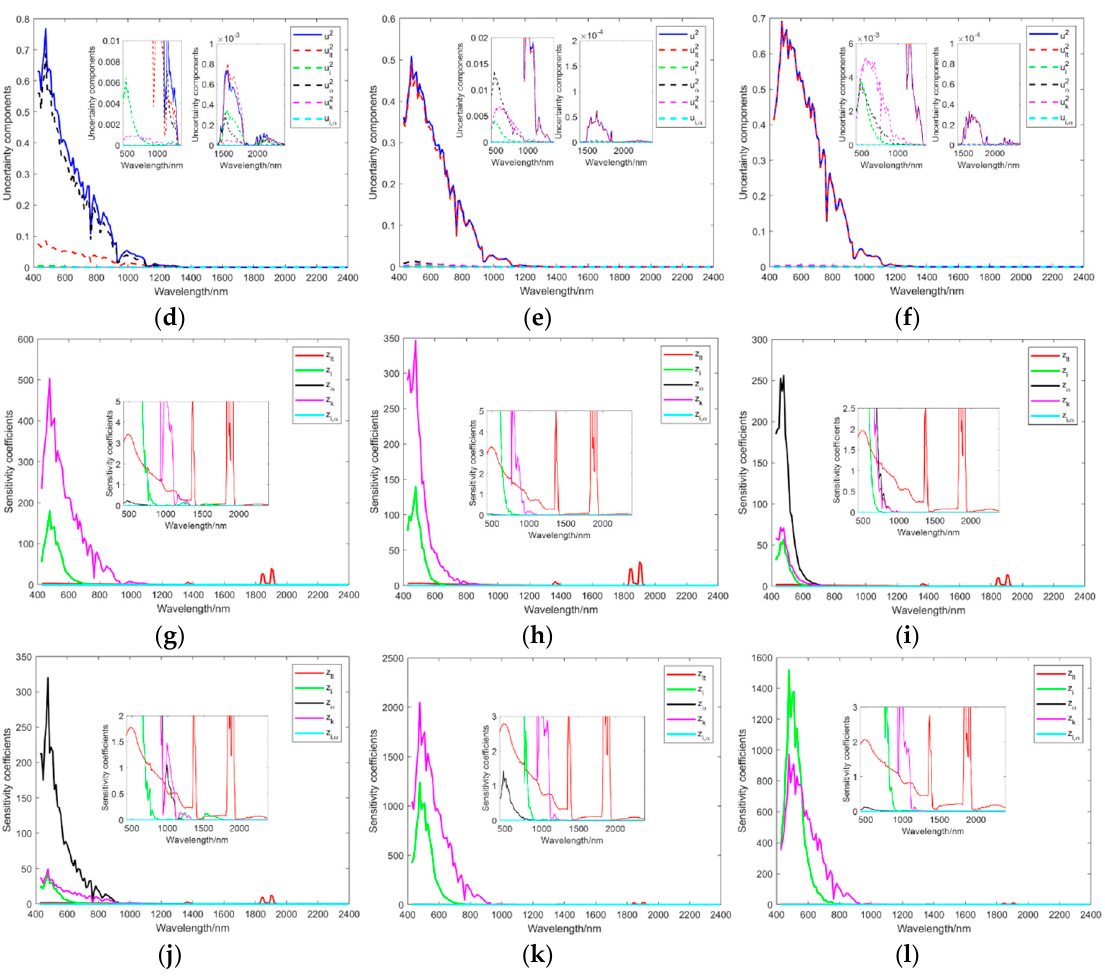
Figure 11. Uncertainty components of Minnaert correction. The subplots ( a – f ) and ( g – l ) represent the uncertainty components and sensitivity coefficients associated with input quantities of the six verification points, respectively. In each subplot of ( a – f ), the blue solid line is the total combined variance of corrected radiance after Minnaert correction; the dashed lines are the uncertainty components associated with L T (red), i (green), α (black), and k (pink), and the correlation components between i and α (cyan). In each subplot of ( g – l ), the lines are the sensitivity coe ffi cients associated with L T (red), i (green), α (black), and k (pink), and the correlation components between i and α (cyan). Every subplot is zoomed in on y-axis as its inner plot to show local details of low-value points.